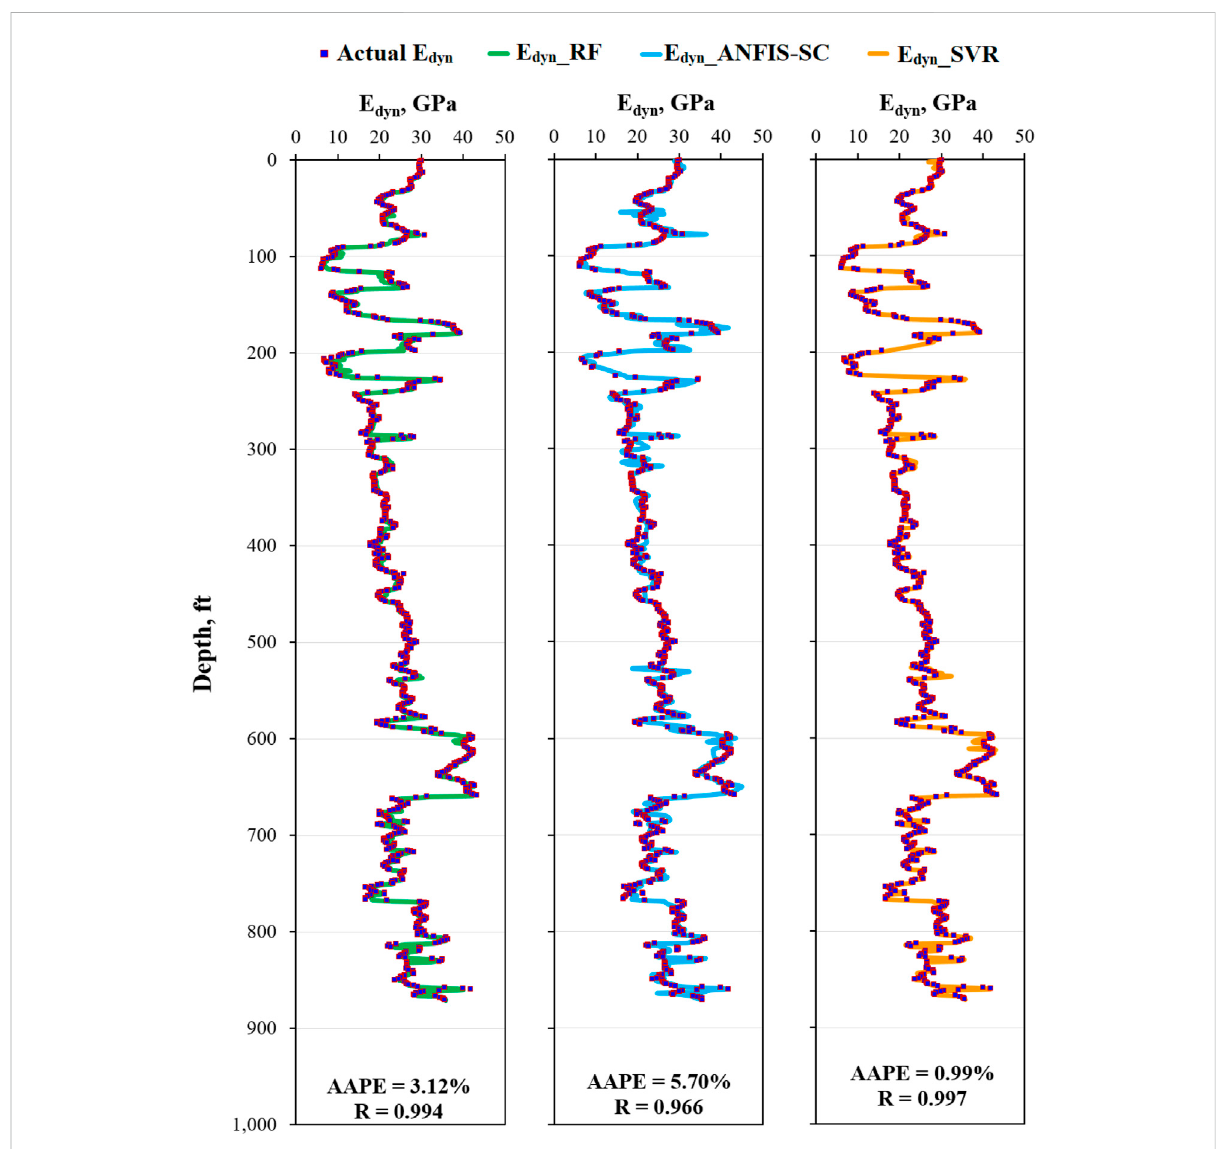
FIGURE 5 Actual and assessed E dyn by the optimized RF, ANFIS-SC, and SVR models for the 871 testing data points of